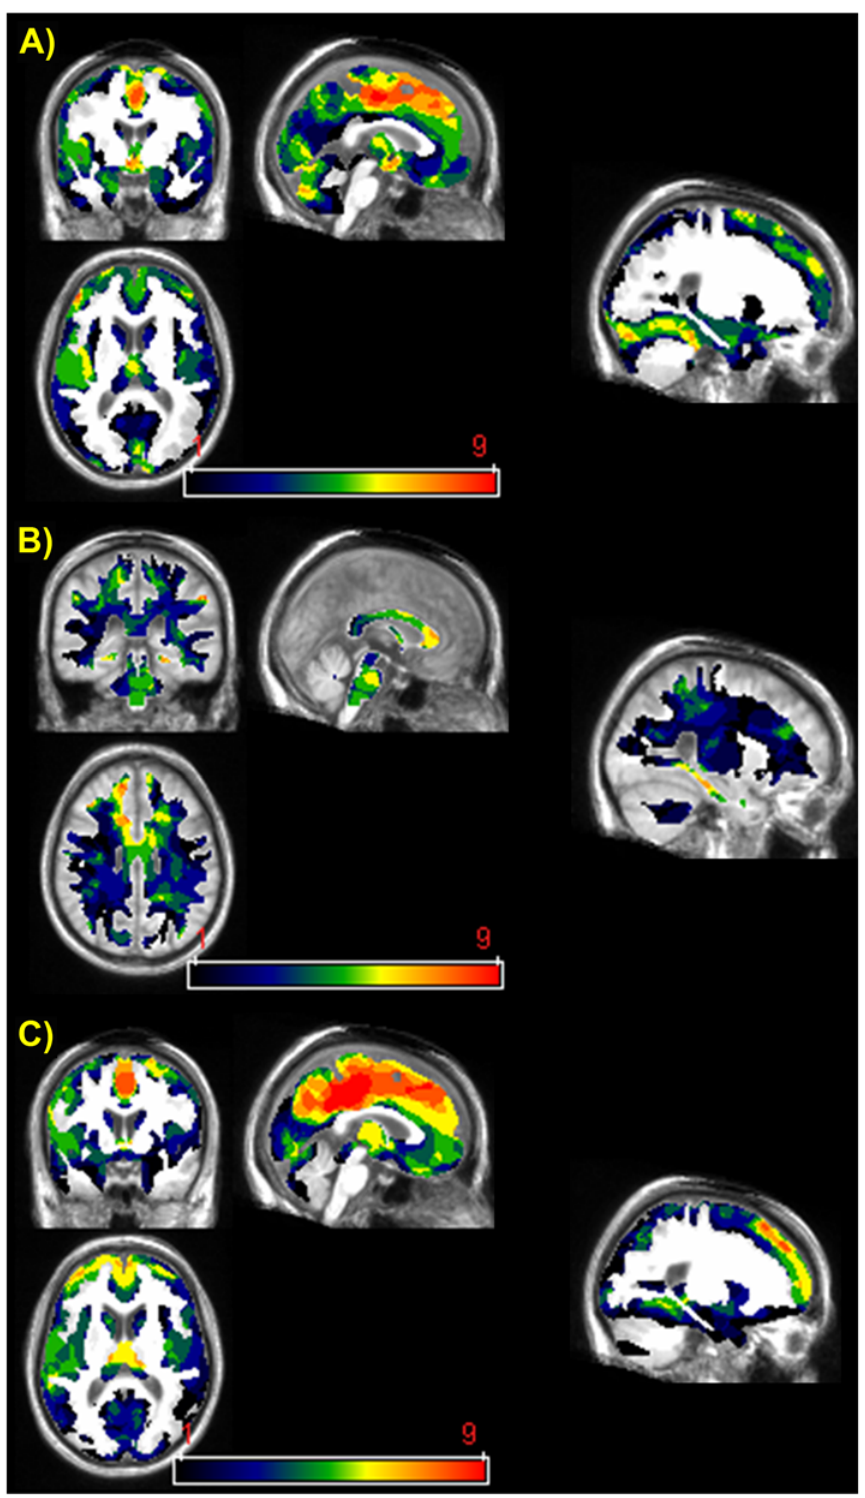
Figure 3. Variability in the individual patterns of GM (A) and WM (B) hypodensity, and GM hypometabolism (C) in the patients with Korsakoff’s syndrome. The colored bar represents the variability of the brain abnormalities across the KS sample from present (red) in all 9 KS patients to absent (black) in all 9 KS.